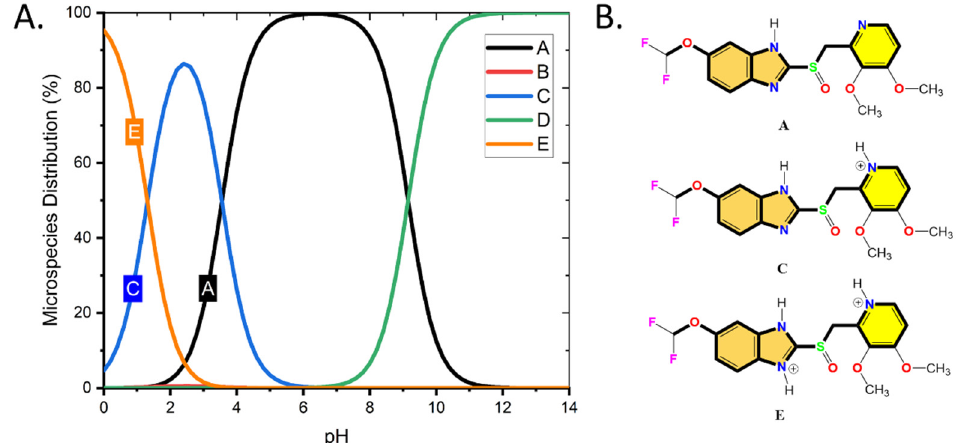
Figure 2. ( A ) The distribution percentage of Pantoprazole molecular forms vs. the pH value of the media and ( B ) three major species distributed at pH < 7 used in the theoretical calculations (DFT, MC, and MD).